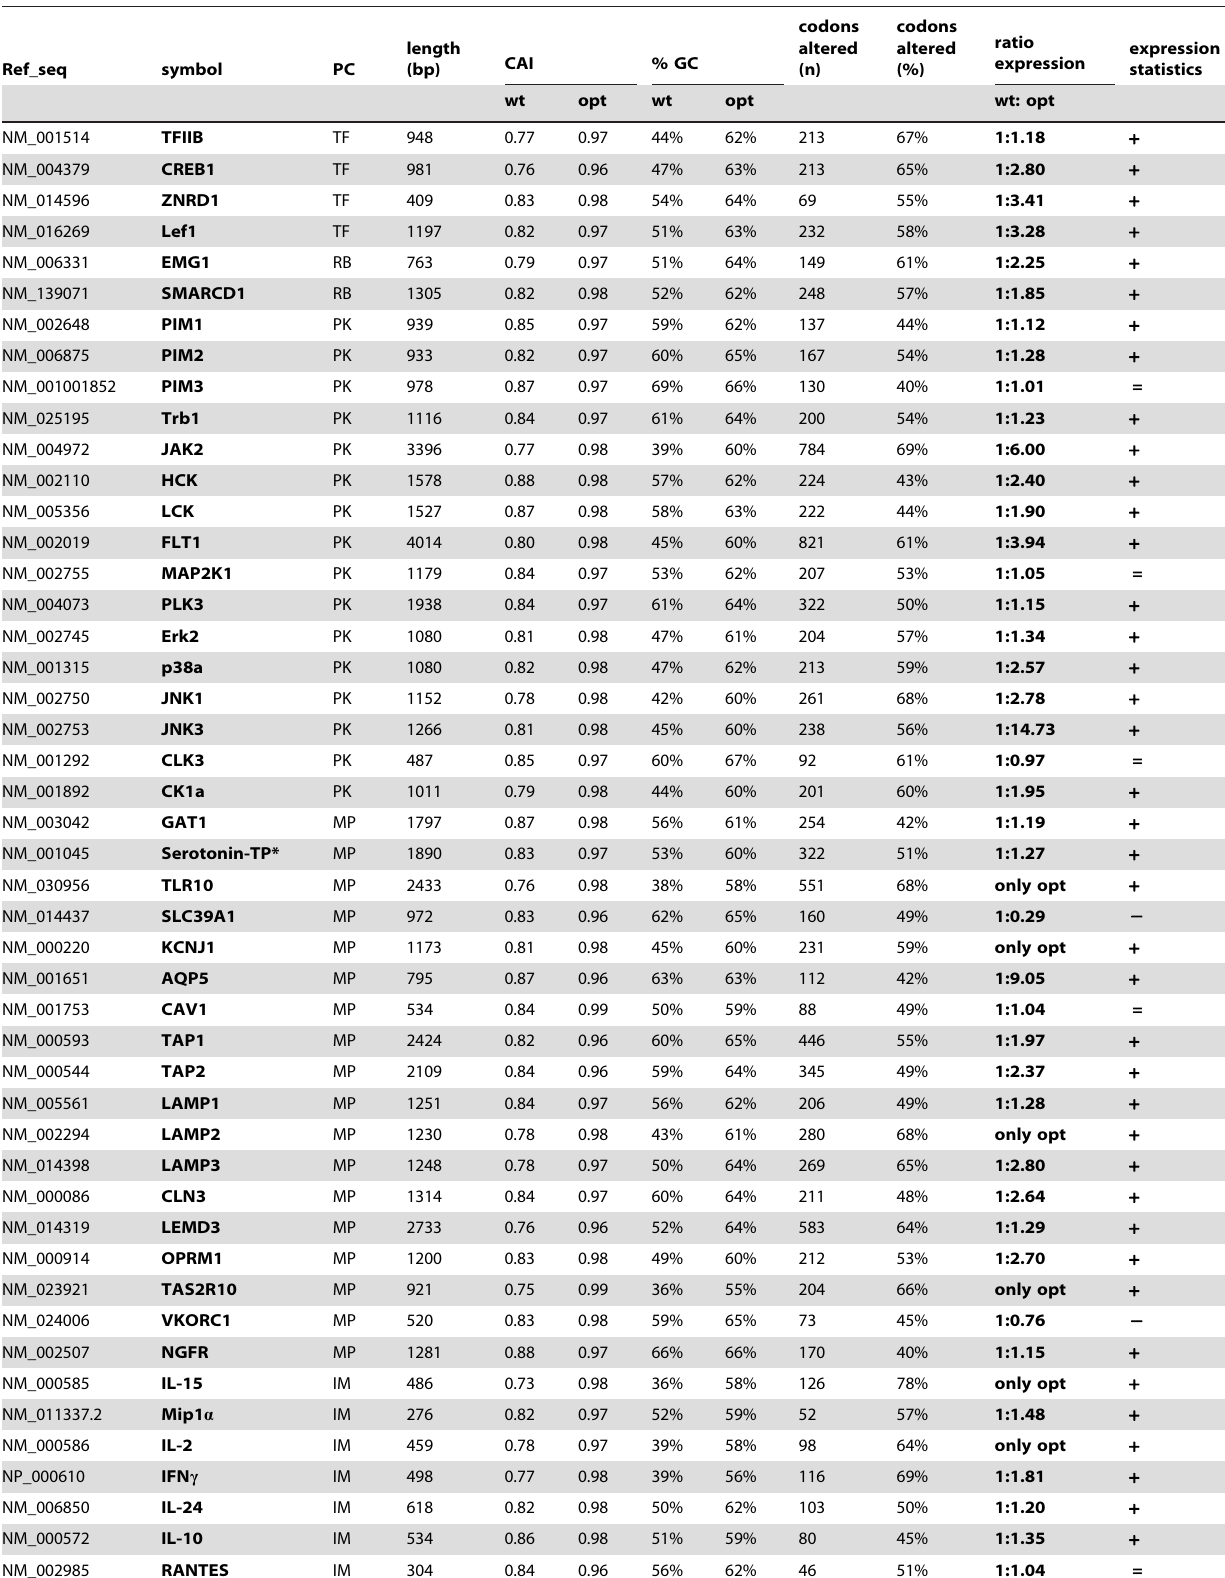
Table 1. Direct comparison of expression levels of 50 wildtype and sequence-optimized human